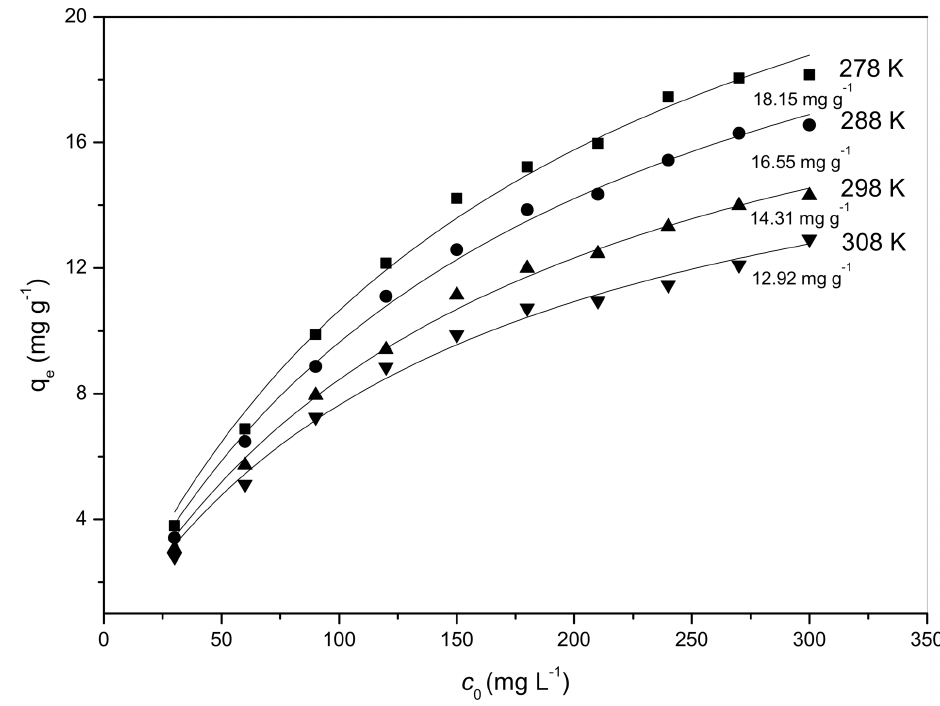
Figure 3. Effect of initial Cd 2 + concentration on the biosorption of Cd 2 + by Sargassumfusiforme .